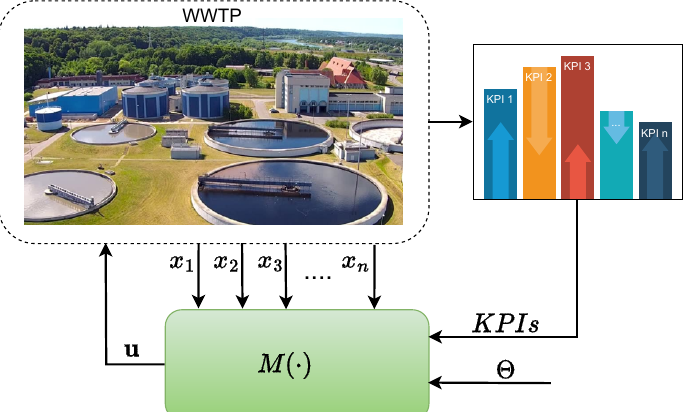
Figure 1. A generic example of a monitoring, control or optimization method ( M ( · ) ) that uses data from process variables ( x 1 , x 2 , . . . , x n ) and KPIs to provide some output(s) ( u ) to optimize the WWTP. Θ are the hyper-parameters of M ( · )